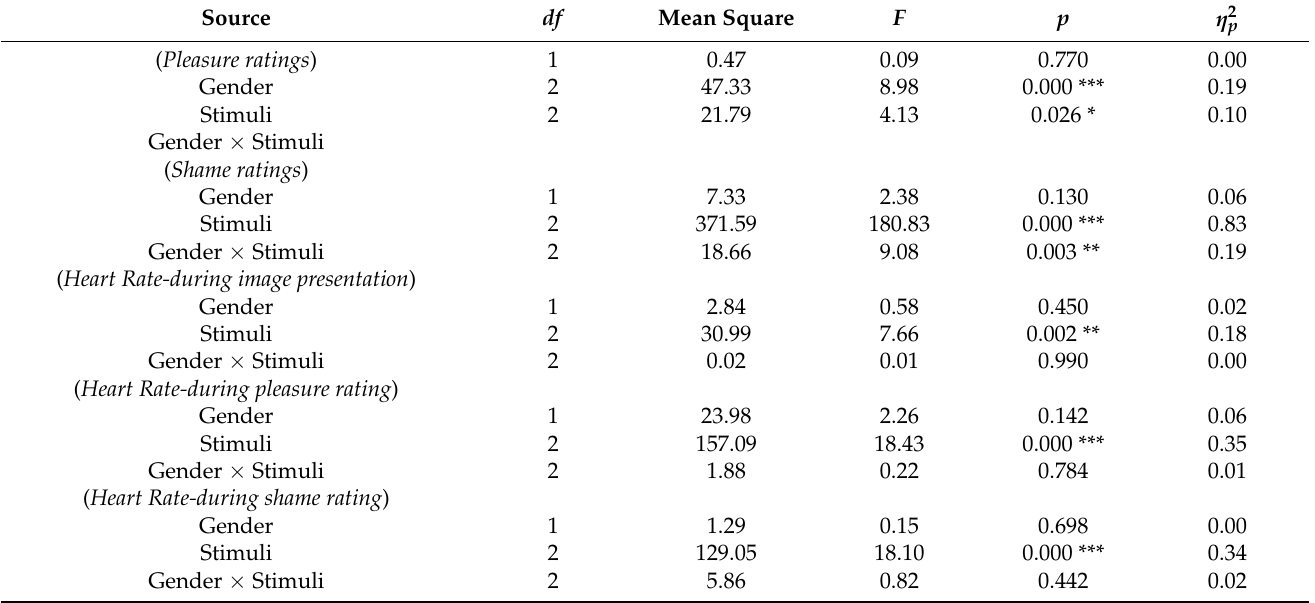
Table 1. Summary of ANOVA results. Both erotic and happy stimuli induced medium pleasure levels in men, but only erotic stimuli did for women. Meanwhile, women reported a higher level of shame compared to men in responding to erotica. In addition, both genders showed comparable heart